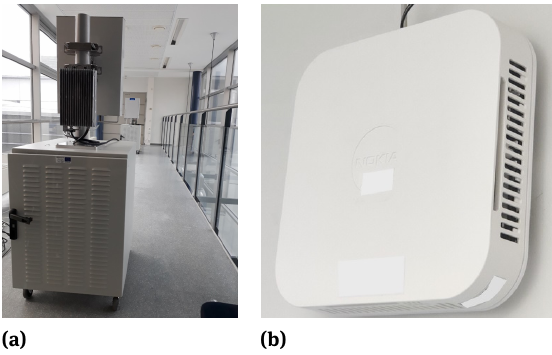
Figure 2: The 5G PoC radio modules (a) and 4G LTE pico base